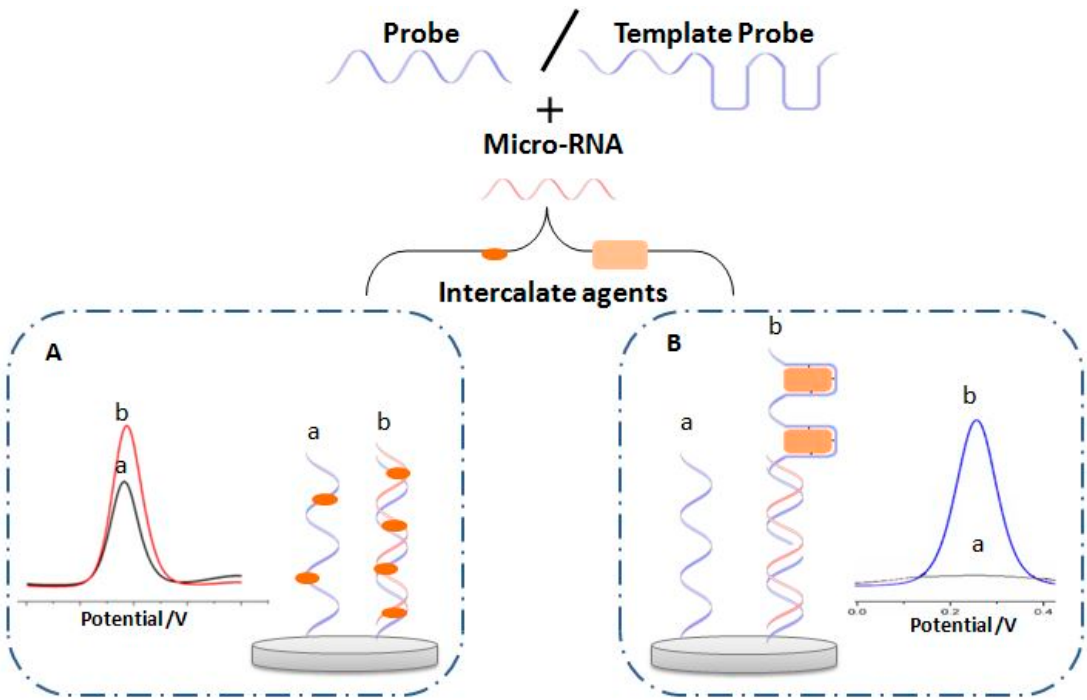
Figure 12. Principal of electrochemical biosensor based on RedOx intercalating agent before ( a ) and after hybridization ( b ) with micro-RNA, ( A ) direct intercalation, and ( B ) intercalation via the template.